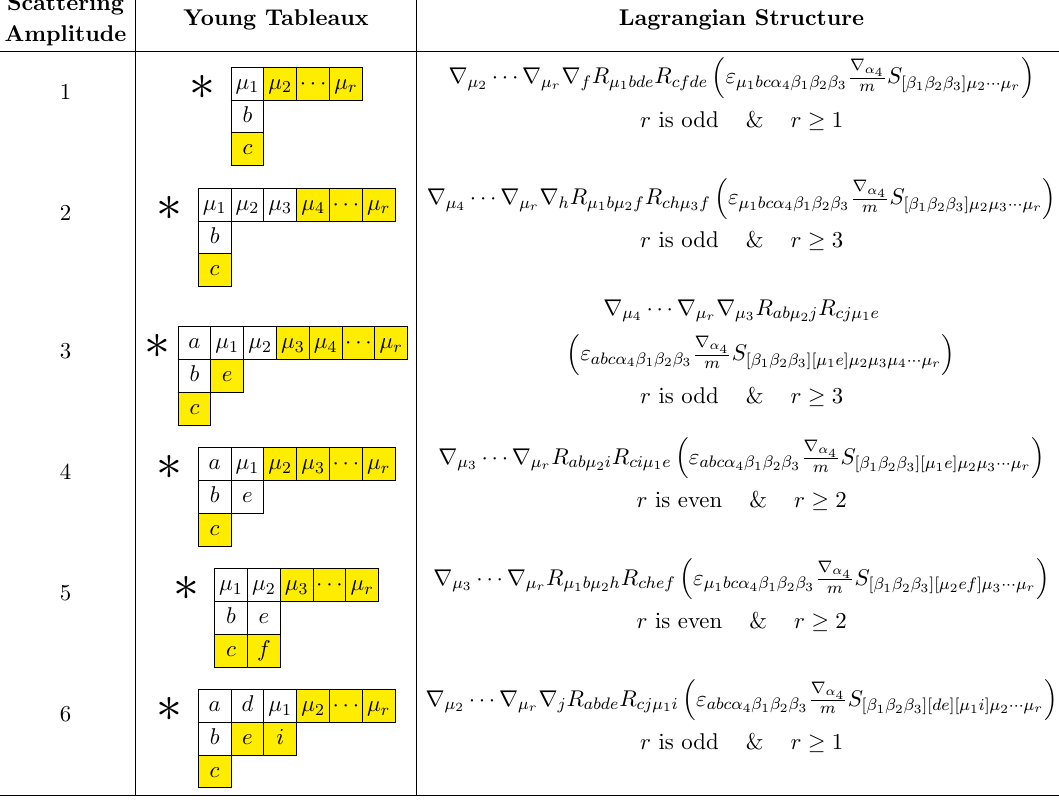
(cid:3) Table 7. Gravitons , D = 7. Here the symbol indicates that the (cid:12)rst column of the original SO(6) Tableaux, in the second column of this table, is Hodge stared (i.e. r.h.s. of (4.4) is